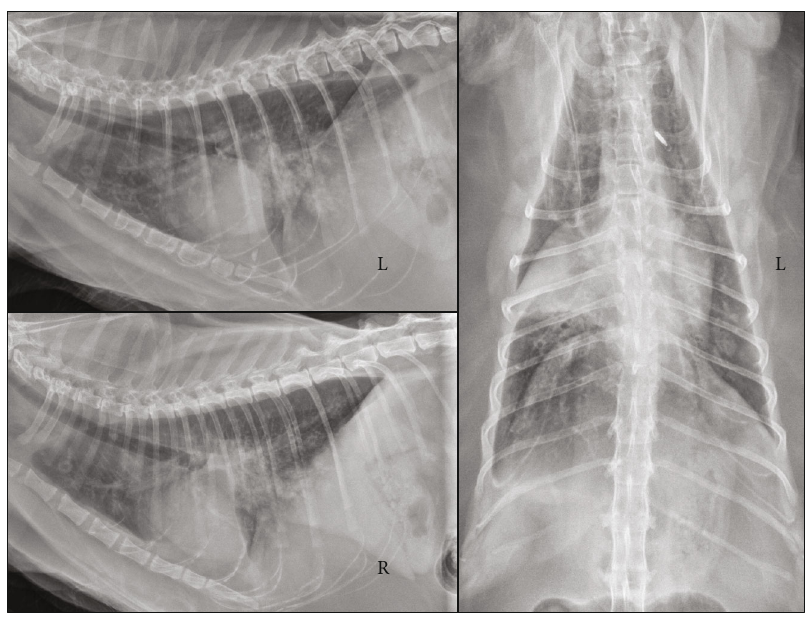
Figure 2: Thoracic radiographs. An alveolar pattern in the right middle lung lobe, di ff use pulmonary nodules, and mild pleural e ff usion are present.